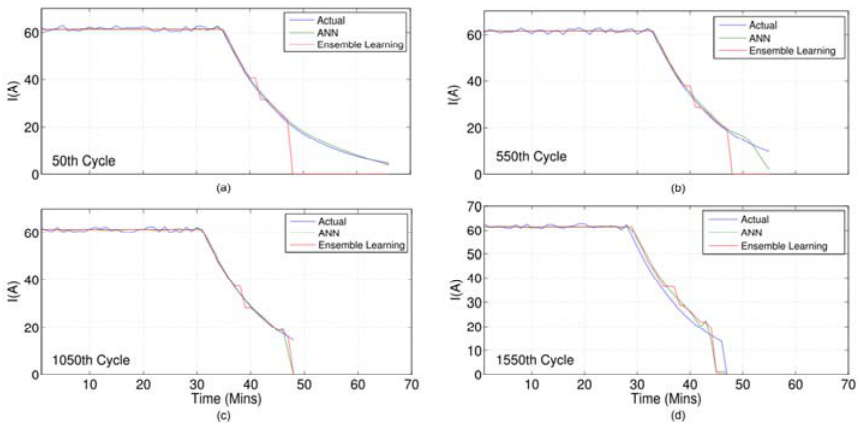
Figure 12. Charging profiles predictions for non-uniform aging of cells-Scale 2. ( a ) 50th Cycle; ( b ) 550th Cycle; ( c ) 1050th Cycle; ( d ) 1550th Cycle.